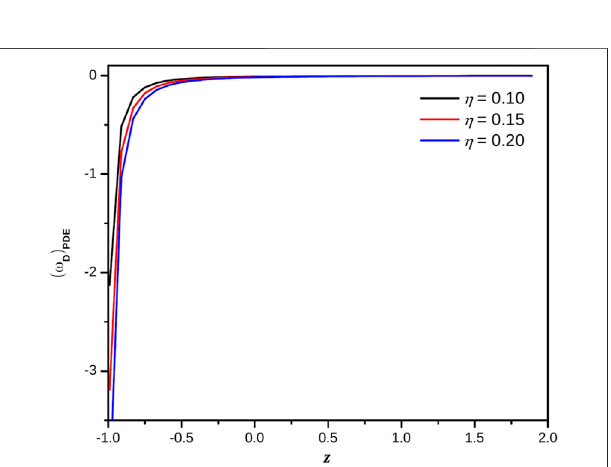
FIGURE11 | Plot ofthe energy density of thereconstructed pilgrim dark energy f ( Q ) gravity model versus redshift for the appropriate choice of constants.